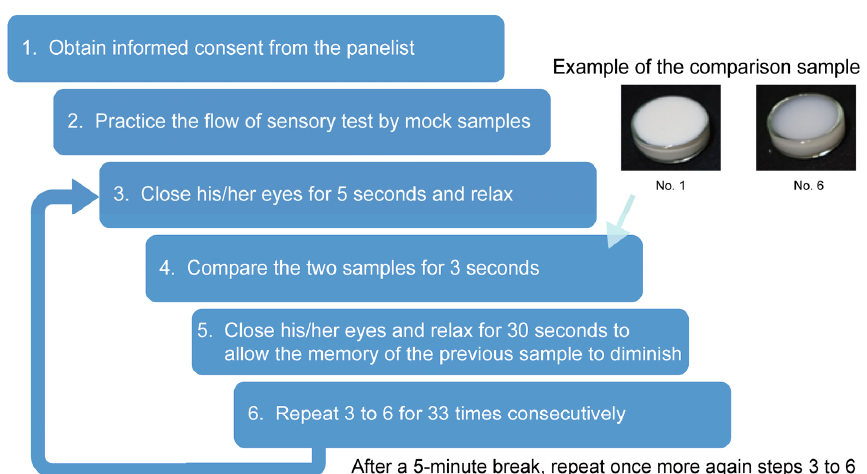
Figure 6. Flow of the sensory test protocol.